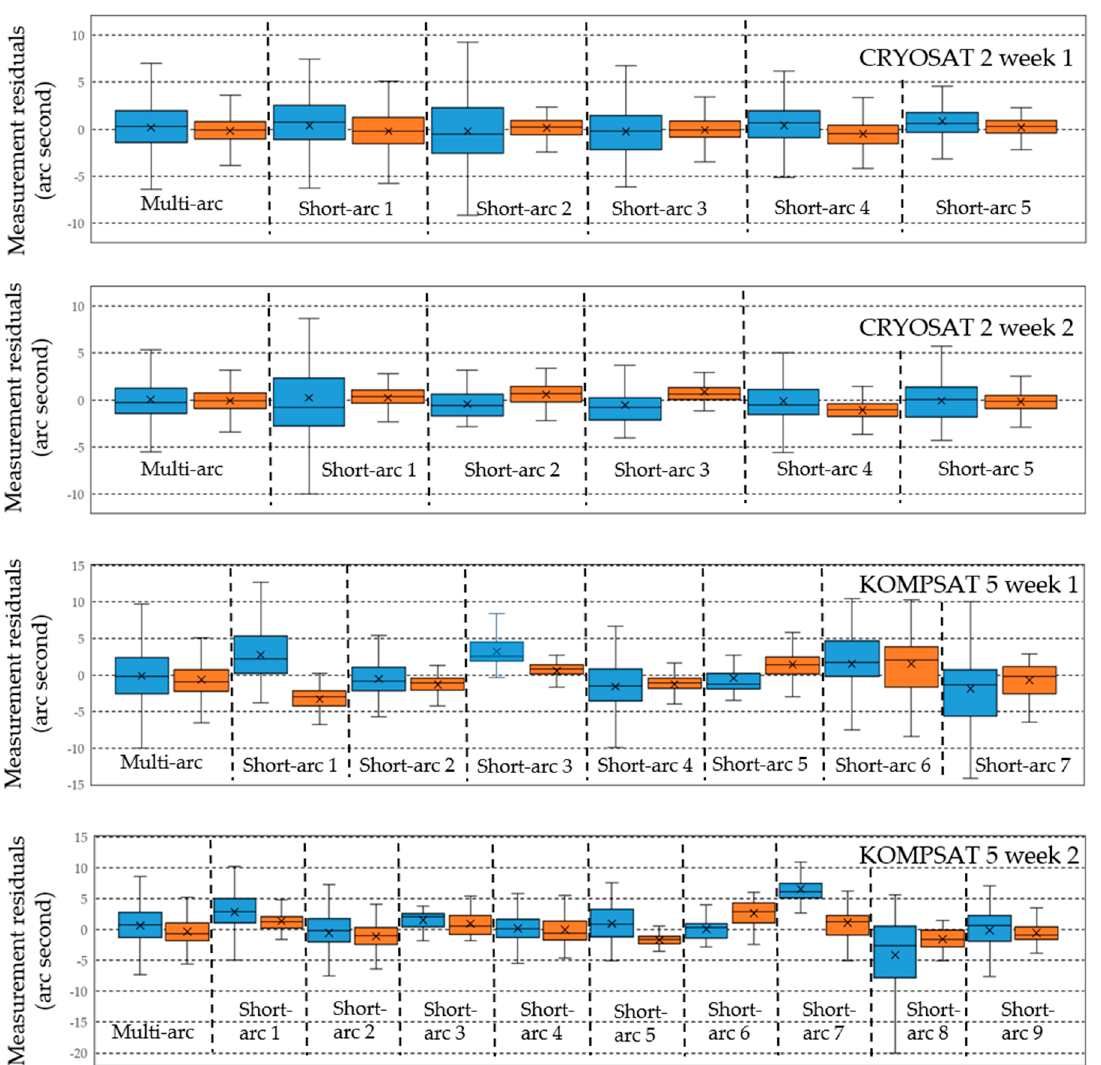
Figure 11. Measurement residuals of multi-arc batch least-squares orbit estimation results and short-arc batch least-squares orbit estimation results for CRYOSAT 2 and KOMPSAT 5 (blue: right ascension, orange: declination). The outliers were neglected. The mean values of the residuals of the multi-arc observations show smaller variation than the mean values of the short-arc observations. The mean values of most residuals do not exceed 5 arc seconds. Table 4. Post-fit residuals (Root-Mean-Square (RMS), arc seconds) of multi-arc and short-arc batch least-squares (BLS) orbit estimation results for CRYOSAT 2 and KOMPSAT 5 (right ascension (R.A.), declination (Dec.)). The short-arc BLS orbit estimation results were similar to the multi-arc BLS orbit estimation results. The estimated atmospheric drag coefficients ( (cid:1829) (cid:3005) (cid:4667) for multi-arc and short-arc BLS orbit estimations for CRYOSAT 2 and KOMPSAT 5 are described.